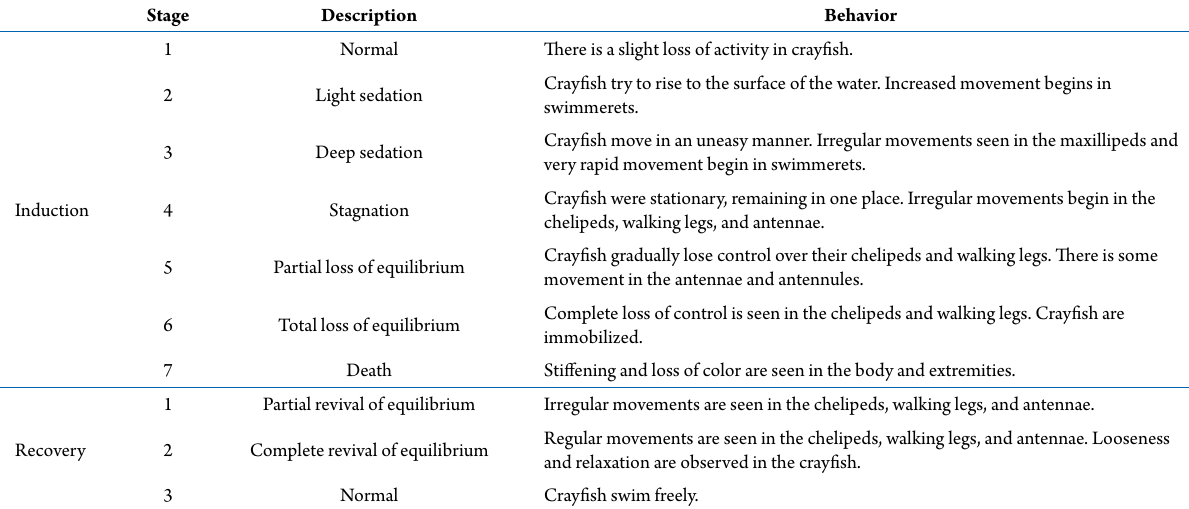
Table 1. Identification of induction and recovery stages in crayfish (the stages were rearranged from Vartak and Singh (2006) and Xie et al. (2010) with considered experimental